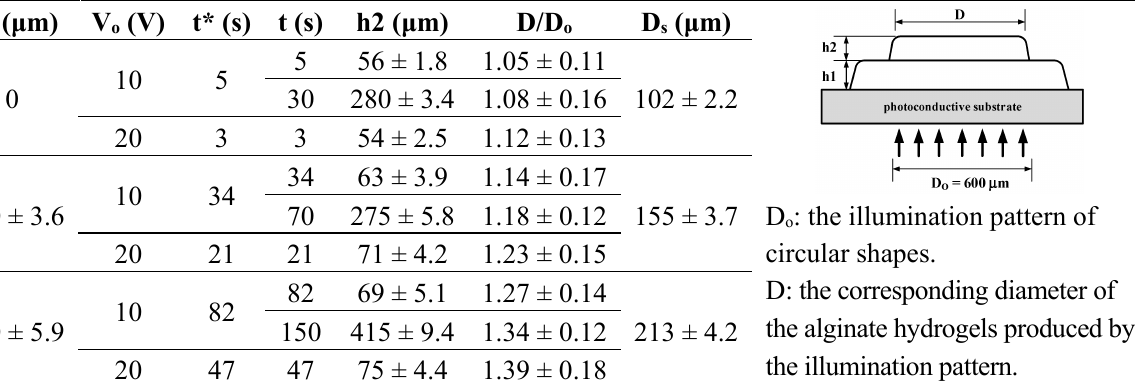
D : the illumination pattern of o circular shapes. D: the corresponding diameter of the alginate hydrogels produced by the illumination